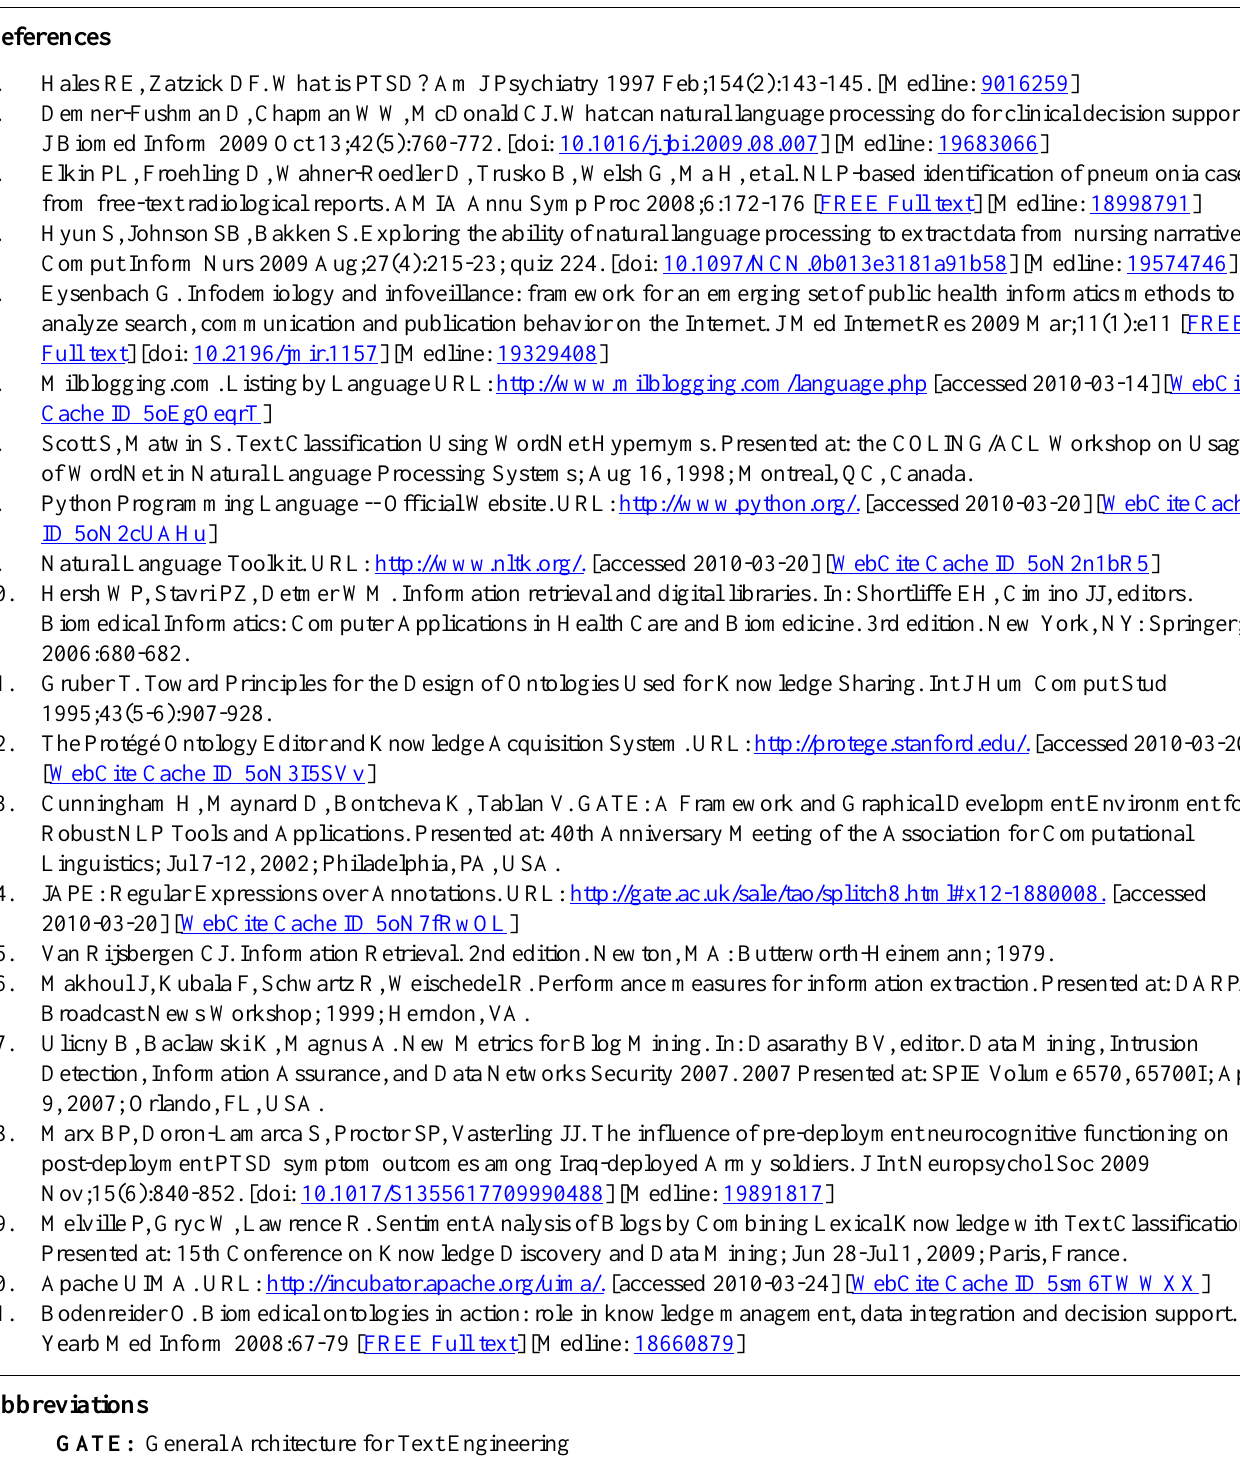
GATE: General Architecture for Text Engineering HSRD: Health Services Research and